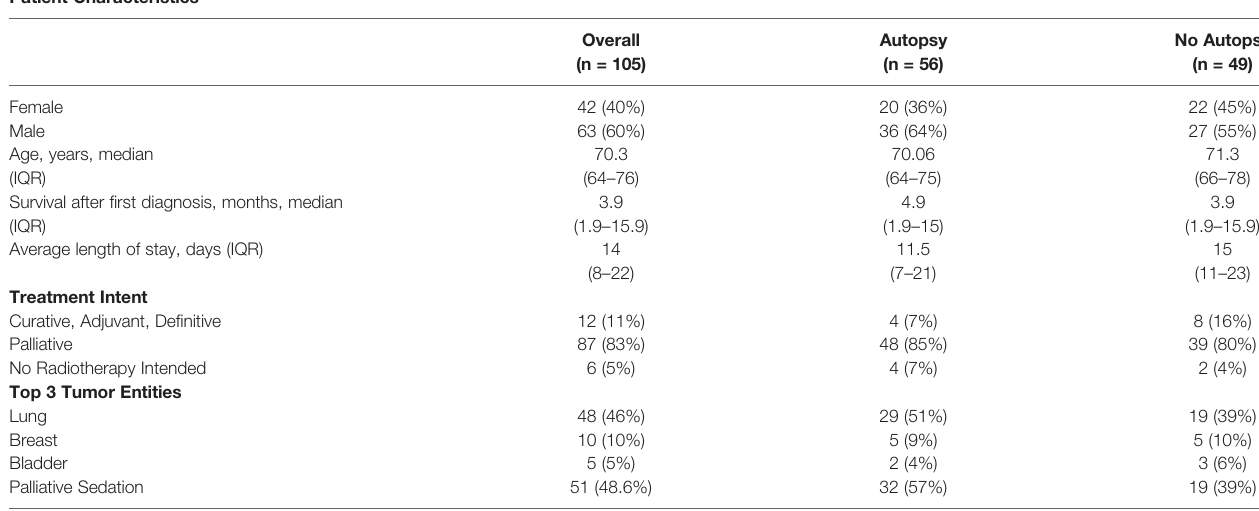
TABLE 1 | Study population overview and patient